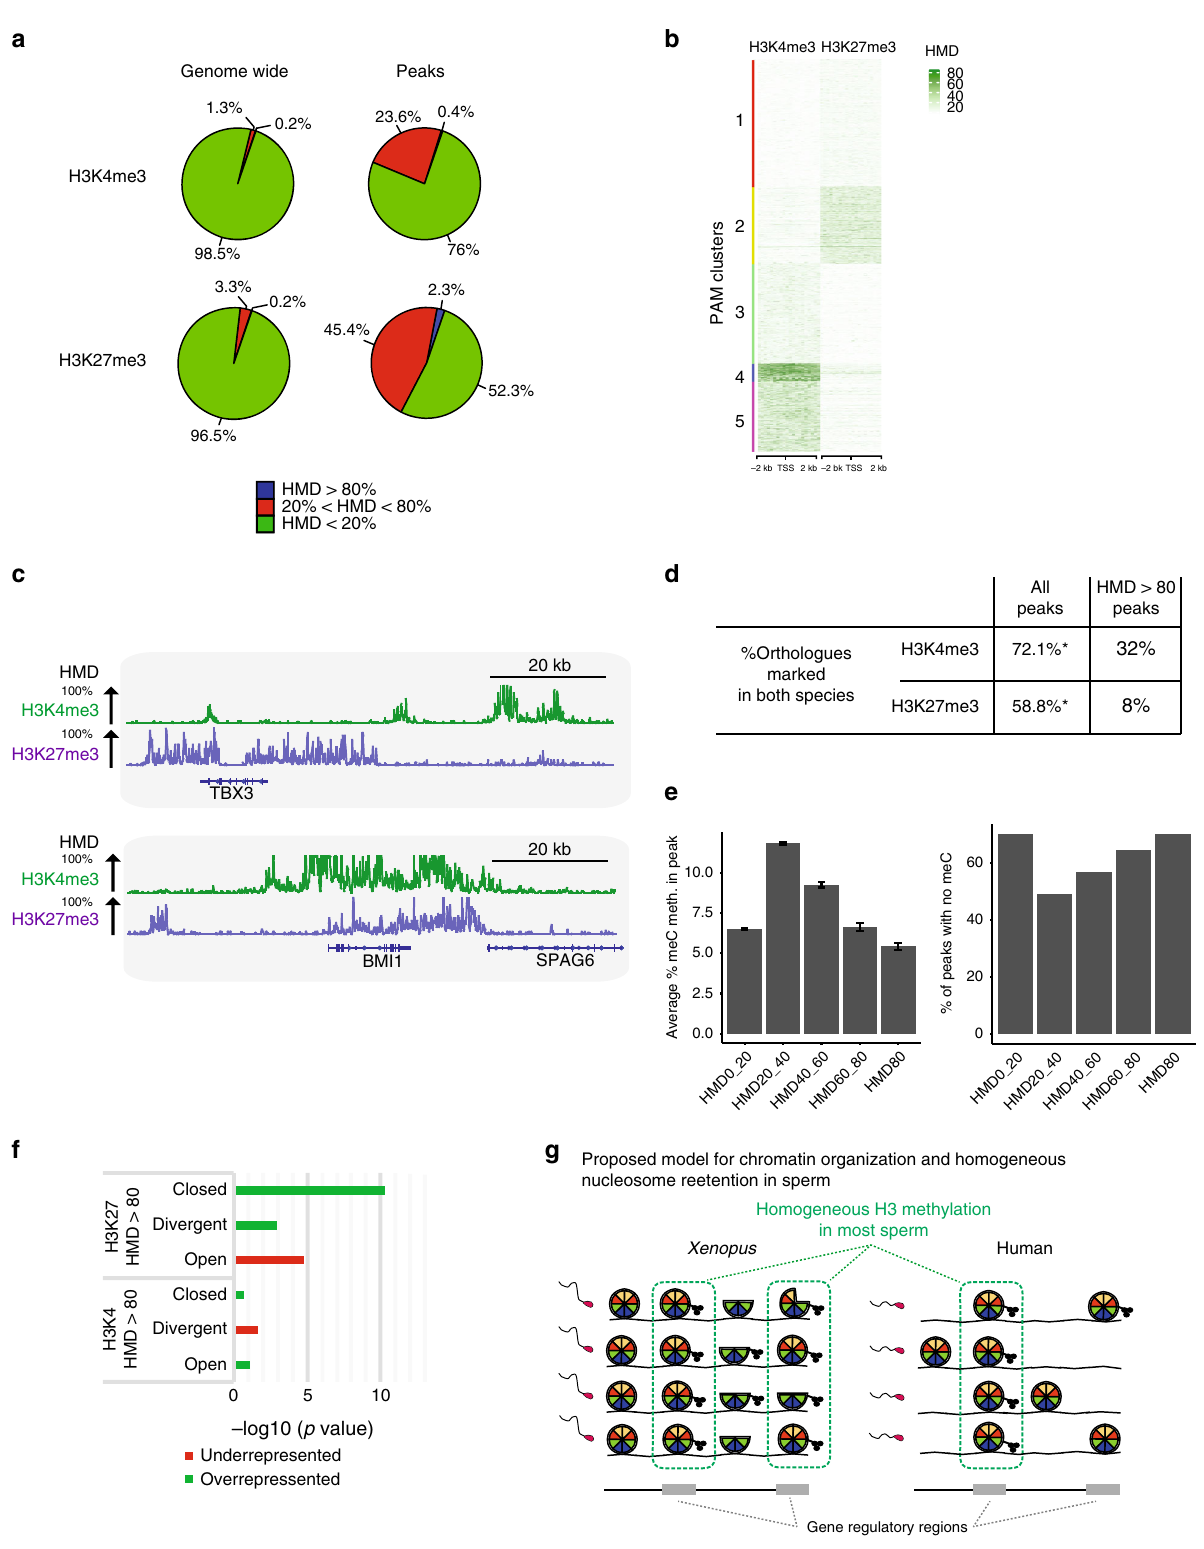
Methods Experimental model and subject details . Mature Xenopus laevis males were obtained from Nasco (901 Janesville Avenue, PO Box 901, Fort Atkinson, WI 53538-0901; https://www.enasco.com/xenopus). Our work with Xenopus complied with all relevant ethical regulations for animal testing and research. This work is covered under the Home Of fi ce Project License PPL 70/8591 and frog husbandry and all experiments were performed according to the relevant regulatory standards.